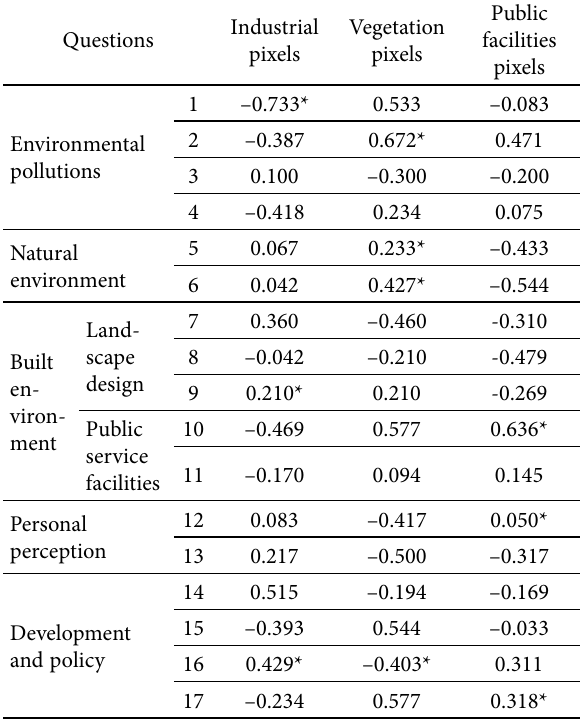
Table 6. Relationships between the landscape features and subjective evaluation. The digital codes are shown in Table 2–3, (* represents p ≤